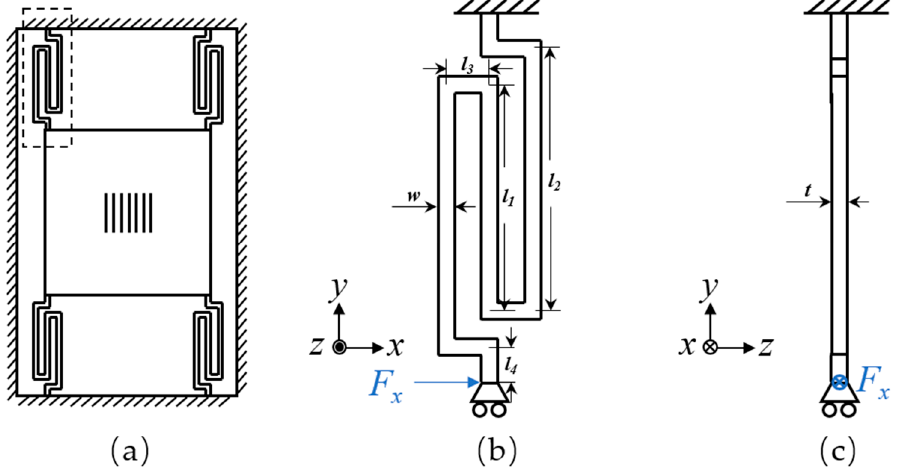
Figure 7. ( a ) Schematic of the elastic micromachined structure with four rotated serpentine springs; ( b ) top view and ( c ) cross-sectional view of a rotated serpentine spring with a guided end. The rotated serpentine spring was chosen due to its low spring constant (high acceleration-displacement sensitivity), small occupation of area, and relatively low cross-axis sensitivity [20]. The schematic diagram of a rotated serpentine spring with a guided end is shown in